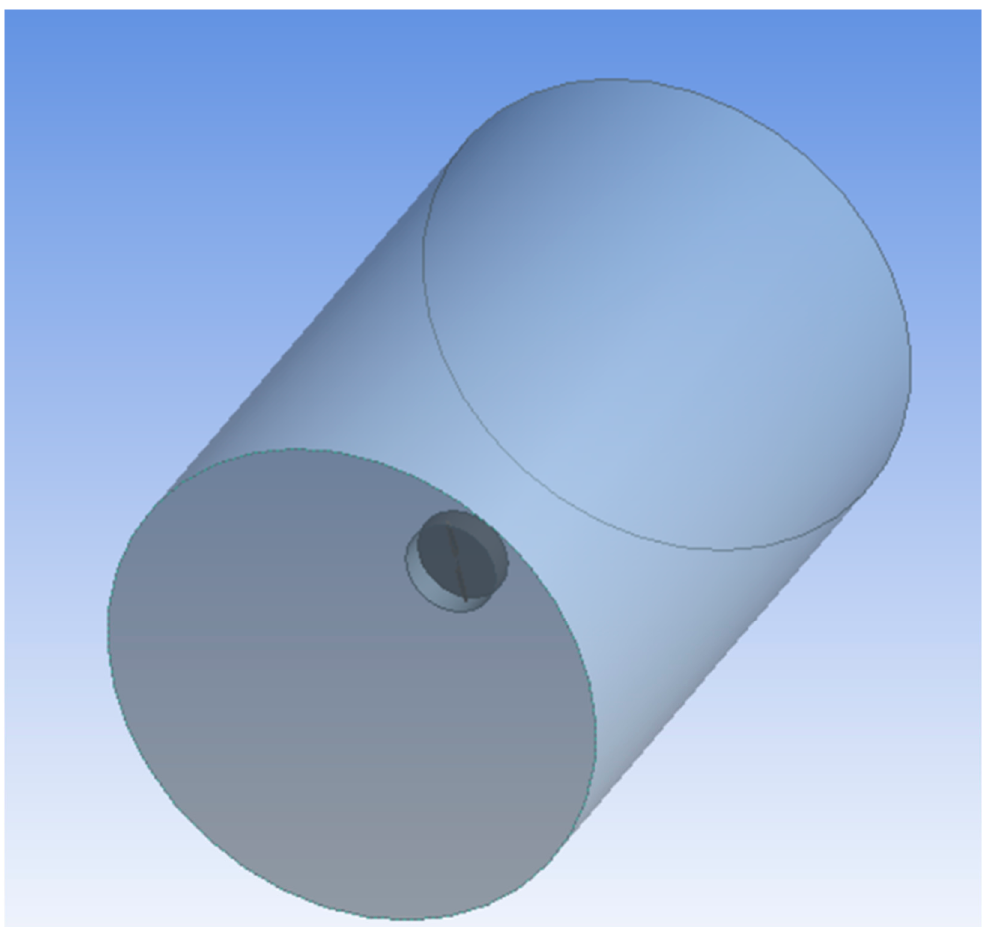
Figure 10. Multi-blocks for Unsteady Reynolds-averaged Navier–Stokes (URANS) simulation.